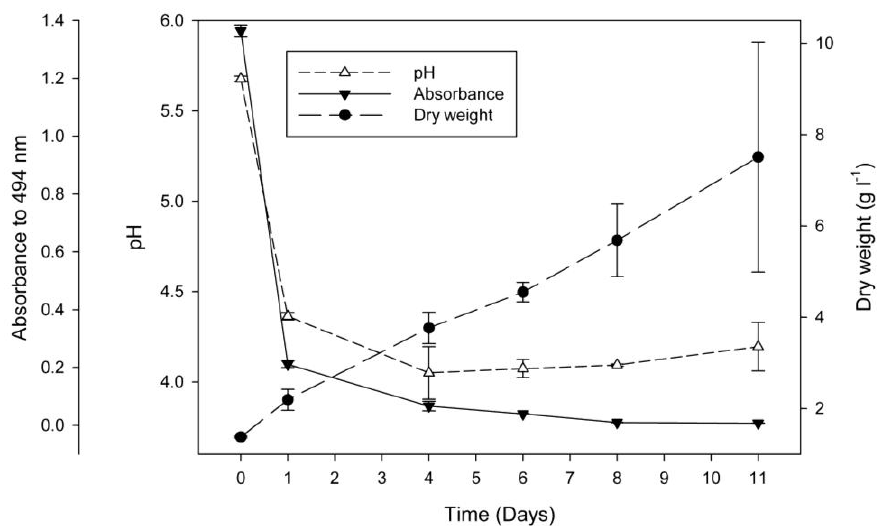
FIGURE 4. Relation between pH, dry weight, and absorbance at 494 nm for treatment 8 in the decolorization of an effluent with cochineal extract using Tv CDBB-H-1051 . Bars represent standard